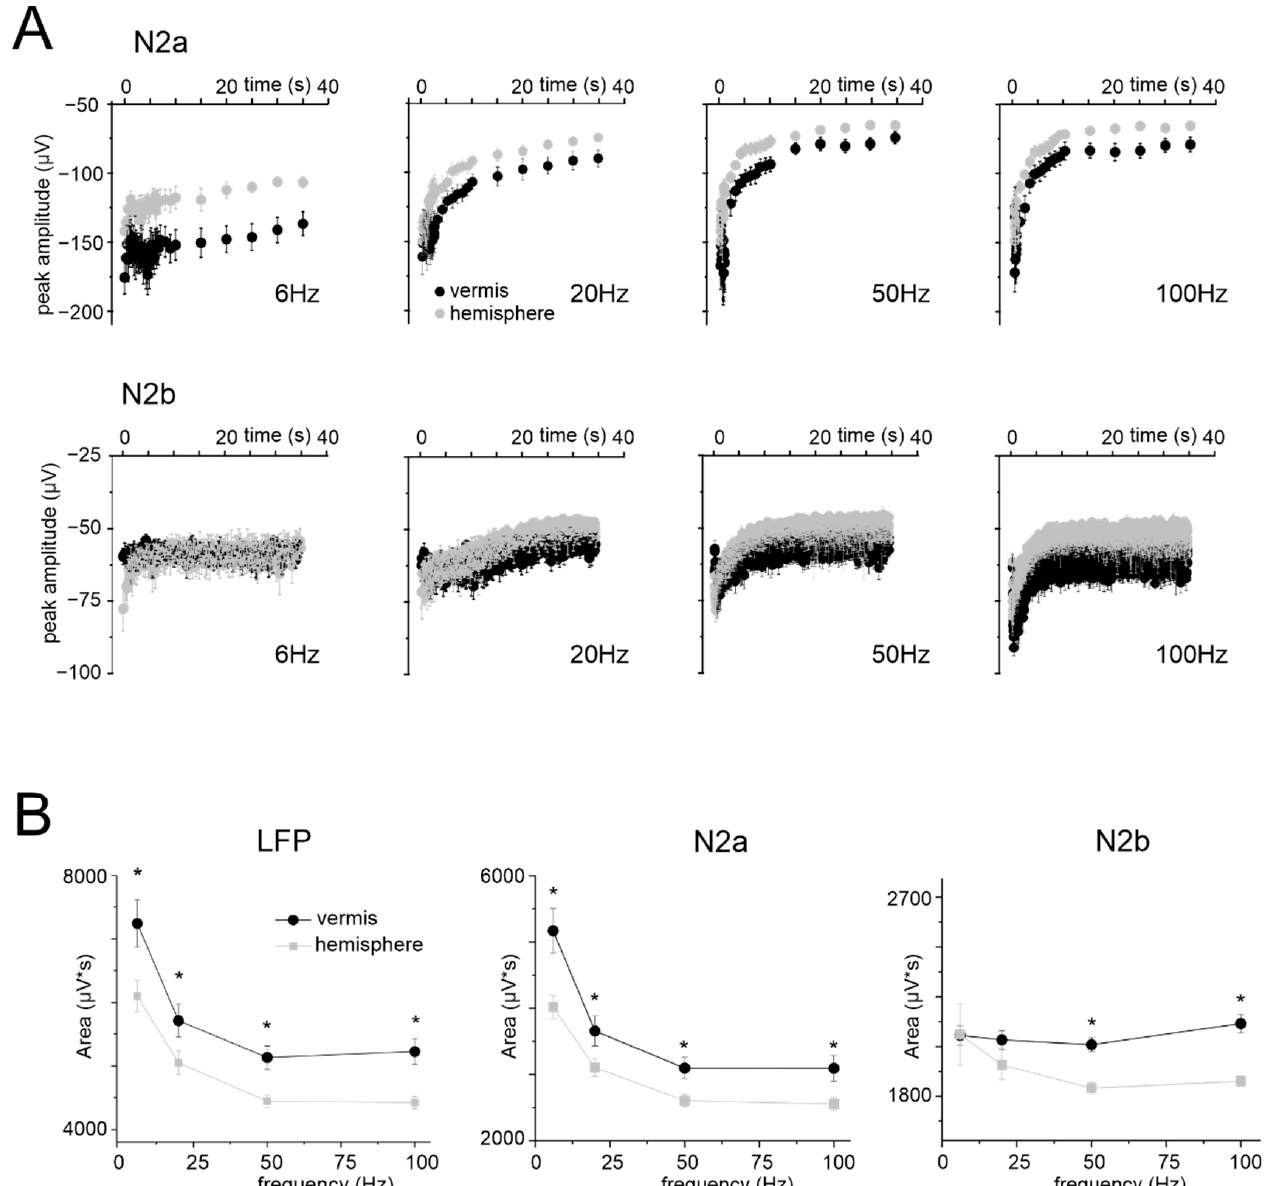
Figure 4. Time and frequency dependence of LFPs during stimulation. ( A ) The plots show the time course of N 2a and N 2b peak amplitude in response to stimulation at different frequencies, recorded in 10 vermis and 10 hemisphere slices (the responses in the right part of the N 2a plots are down-sampled). ( B ) Frequency dependence of the average cumulative LFP response, N 2a and N 2b measured at 35 s during stimulation at different frequencies in the vermis ( n = 10) and hemisphere ( n = 10) (same slices as in panel ( A )). Statistical significance is indicated by asterisks (* p < 0.05).